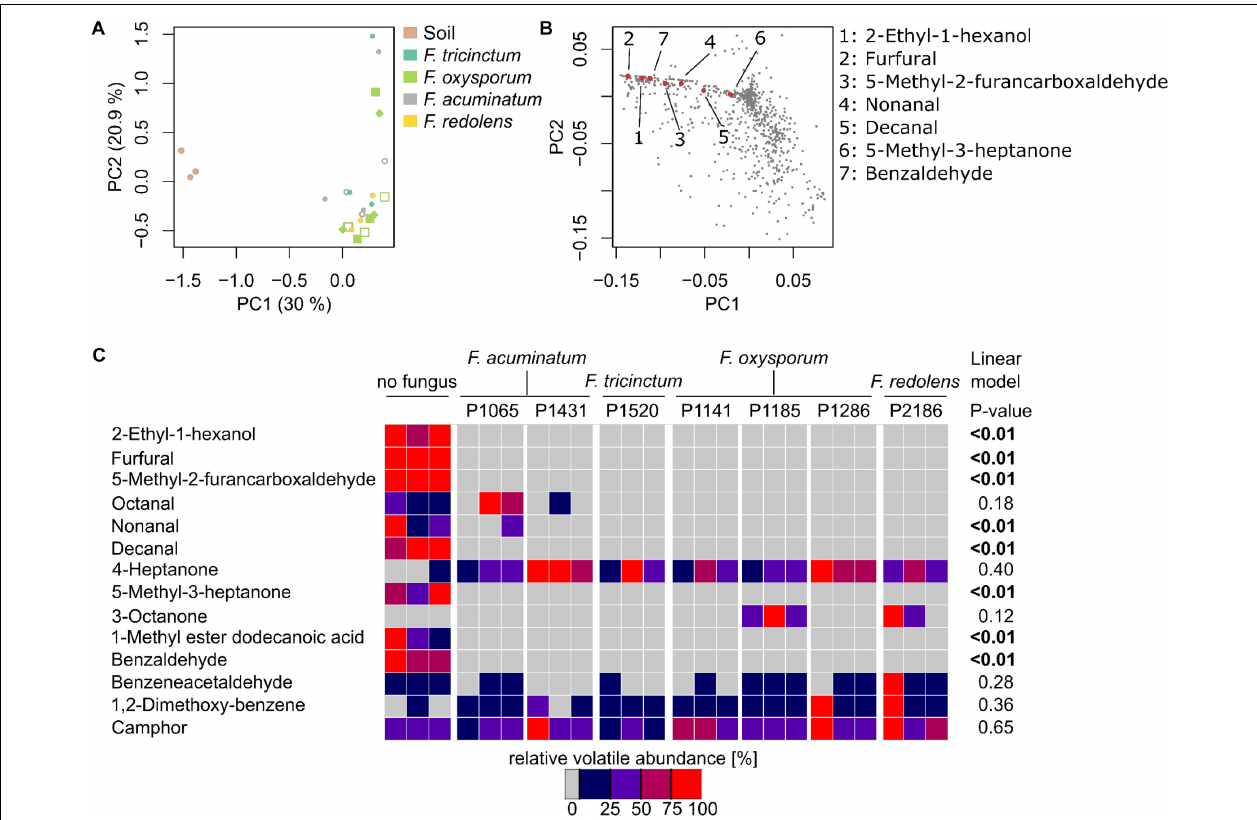
FIGURE 5 | Fusarium spp. reduces the emission of soil VOCs. (A) Principle Coordinate Analysis ordination (PCoA) based on VOCs emitted by non-inoculated soil and Fusarium -inoculated soil samples highlights major differences among non-inoculated and Fusarium -inoculated soil ( n = 3 replicates per strain). (B) PCoA illustrating the distribution of TAGs (VOCs) across samples, showing those responsible of the differences observed in (a). Red, numbered dots correspond to identified VOCs. (C) Heatmap illustrating the concentration of 14 identified VOCs in n = 3 replicates ( Supplementary Figure S5 includes unidentified VOCs as well) and highlighting that non-inoculated soil tends to have a higher concentration of VOCs compared to Fusarium -inoculated soil. P -values reported on the right side of the heatmap correspond to significant negative correlations among VOC concentration and primary root length (reported in Figure 3 ) obtained through a linear